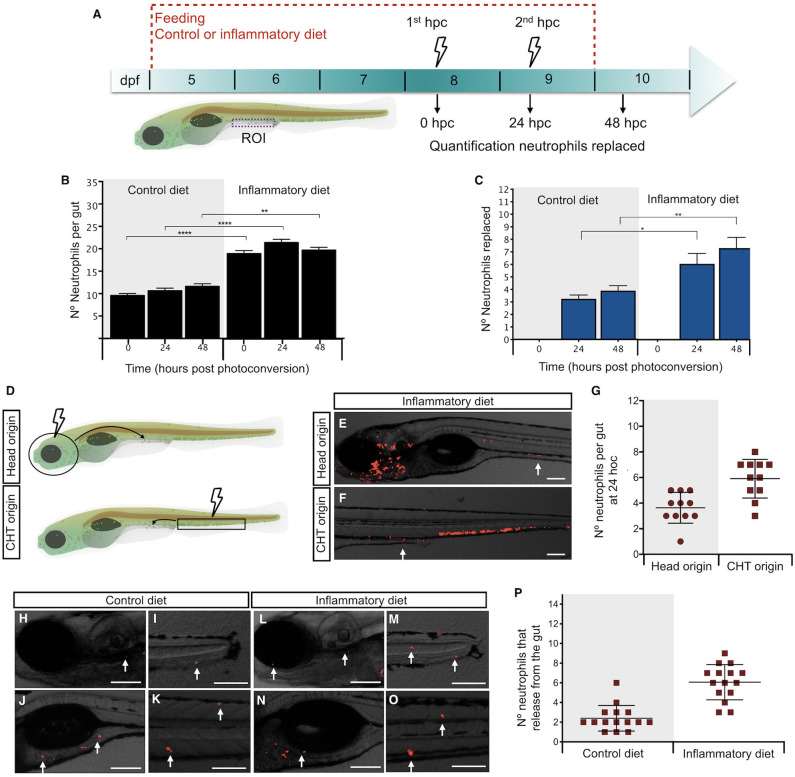
Intestinal inflammation induced by soybean meal increases neutrophil turnover. (A) Experimental strategy used in (B,C,H–P). Larvae at 5 dpf were fed with control or inflammatory diet for 6 days. Then, 1st and 2nd photoconversion of neutrophils present in the intestine was performed at 8 and 9 days post-fertilization (dpf), respectively. Quantification of red- and green-neutrophils present at midintestine (purple dotted line) at 0, 24, and 48 h post-photoconversion (hpc) was performed. (B) Quantification of the total amount of neutrophils present in the intestine at 0, 24, and 48 h post-photoconversion (hpc) in control and inflamed larvae. (C) Quantification of the number of neutrophils replaced at 24 and 48 hpc in control and inflamed larvae. (D) Experimental strategy used in (E–G). The head (circle) or caudal hematopoietic tissue (CHT, rectangle) region was photoconverted at 8 dpf larvae. Later, at 24 hpc red-head-neutrophils and red-CHT-neutrophils present in the intestine were quantified. (E,F) Representative images showing red-head-neutrophil or red-CHT-neutrophils infiltrated in the intestine at 24 hpc in inflamed larvae. (G) Quantification of head and CHT photoconverted neutrophils in the intestine after 24 hpc. (H–O) Representative images showing the region of the body (head, caudal fin, anterior intestine, trunk) where intestine-derived neutrophils were found. (P) Quantification of the number of neutrophils that left the intestine at 24 h. Statistical analysis was performed with the Mann–Whitney U test. ns., non-significant, *p < 0.05, **p < 0.01, and ****p < 0.001. Scale bar, 200 um.